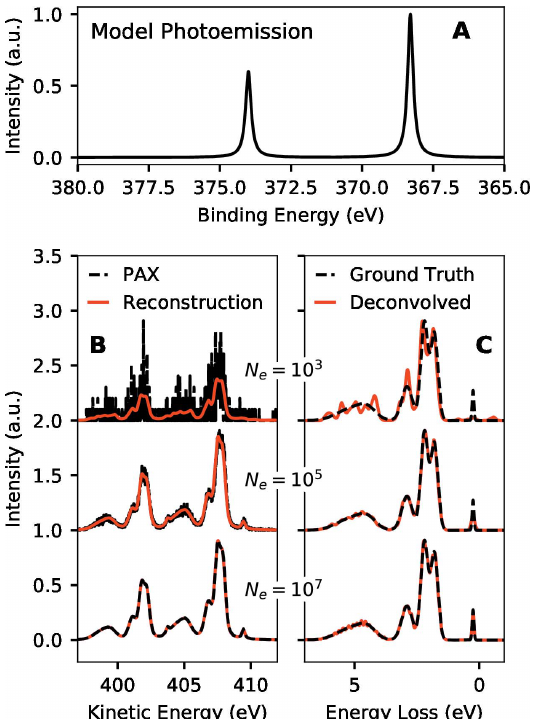
Figure 9 Simulated performance of PAX in estimating a model RIXS spectrum using a model Ag 3 d photoemission converter. (A) Model Ag 3 d photoemission spectrum with 233 meV FWHM Lorentzian peaks (Panaccione et al. , 2005). (B) Simulated PAX spectra as well as the reconstruction of that data from the deconvolved results as a function of number of simulated detected electrons in the PAX spectra ( N e ). (C) RIXS spectra estimated through deconvolution of the simulated PAX data. The ground truth spectrum is also shown for each